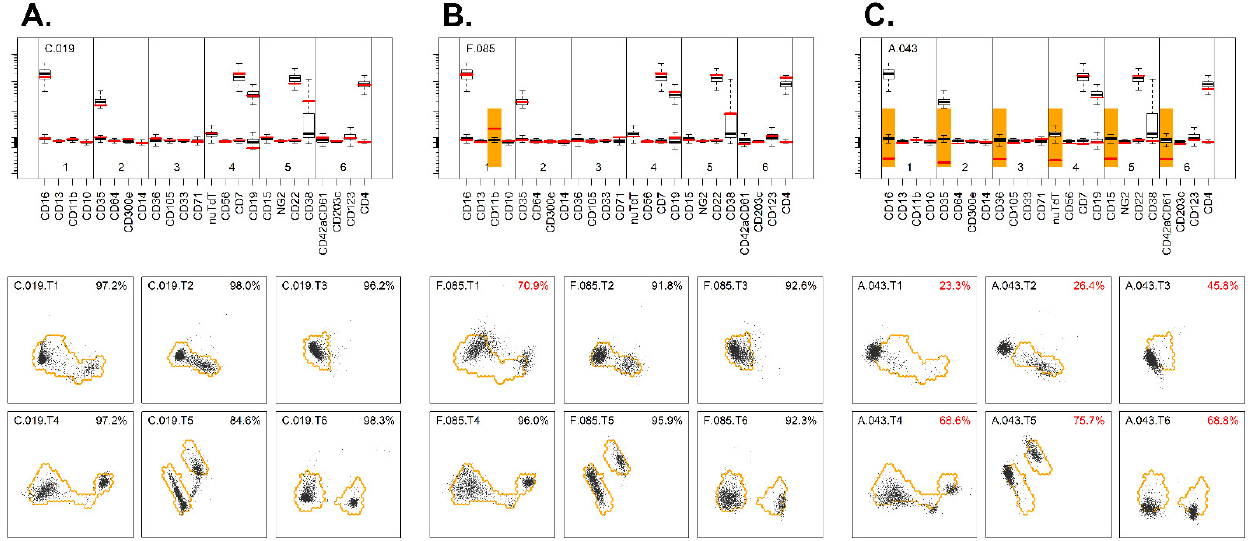
Figure 3. Evaluation of the tube-specific markers using PCA. ( A ) Example of a sample where expression of TS markers on lymphocytes was well within the reference for each tube (lower panel). Median expressions of TS markers of the patient’s lymphocytes (red lines) were close to the median values of the reference cases (upper panel). ( B ) Example of a sample where the expressions of TS markers on the lymphocytes of all but one tube were well located within the reference region (lower panel). The lymphocytes in tube 1 were, however, partly outside the reference region, and the direction is suggestive for abnormalities in CD11b expression. The median value of the patient’s lymphocytes (red lines) for CD11b in tube 1 were clearly higher than the median values of the reference cases (upper panel). ( C ) Example of a sample where the expressions of TS markers on the lymphocytes of all six tubes were located outside the reference region for one specific fluorescence channel (FITC) (lower panel). The median expressions of the FITC-conjugated markers (red lines) were clearly below the median expressions of the reference cases, which may indicate incorrect compensation settings (upper